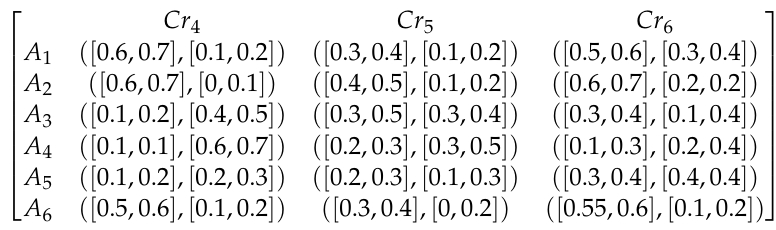
Algorithm 1 is used to solve the selection